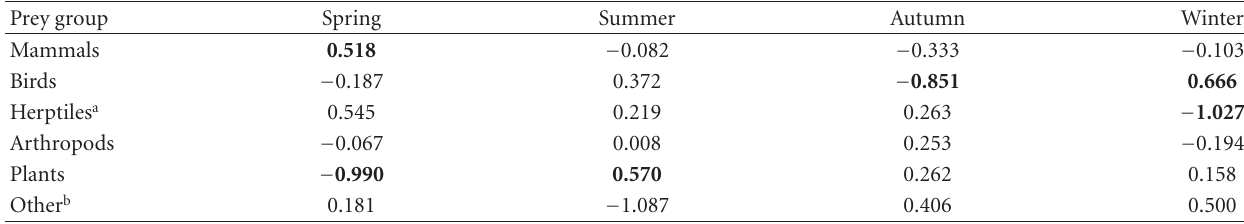
Table 3: Parameters ( λ ) of the interaction term season × food in the log-linear model. Bold number indicates significant contribution of the parameter to the model by using the 95% confidence interval